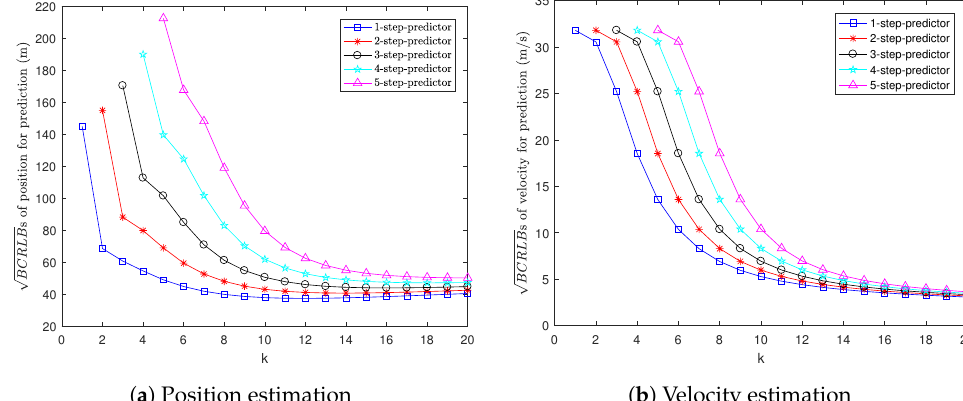
√ Figure 5. BCRLBs for prediction in Example 2.